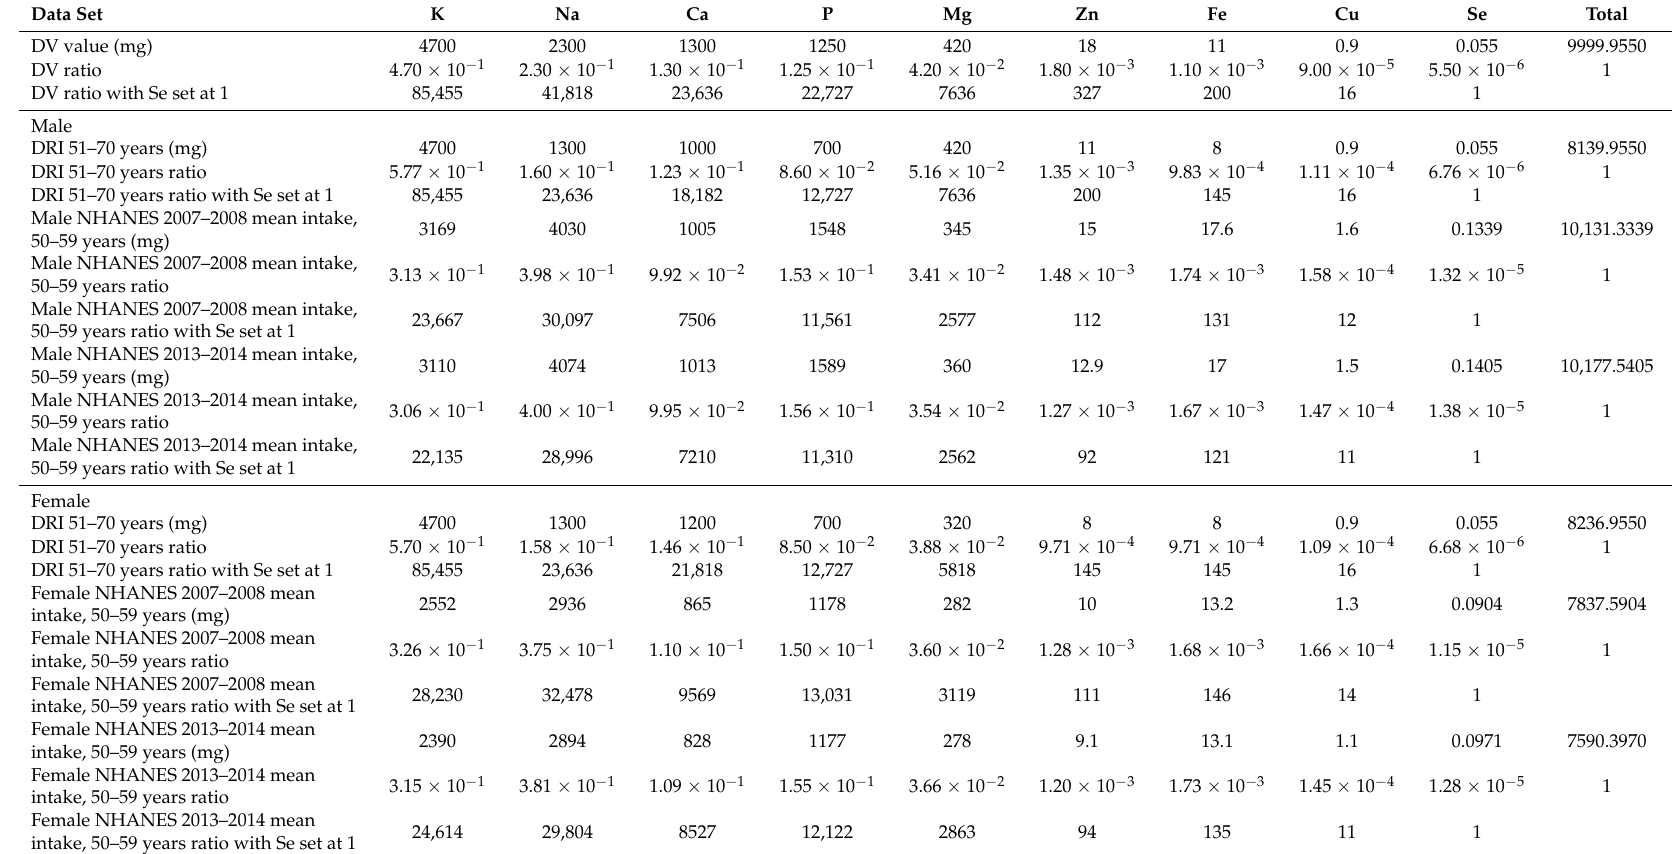
Table 1. The Dietary Reference Intakes (DRI), Daily Value (DV) and dietary mineral intakes from food (National Health and Nutrition Examination Survey